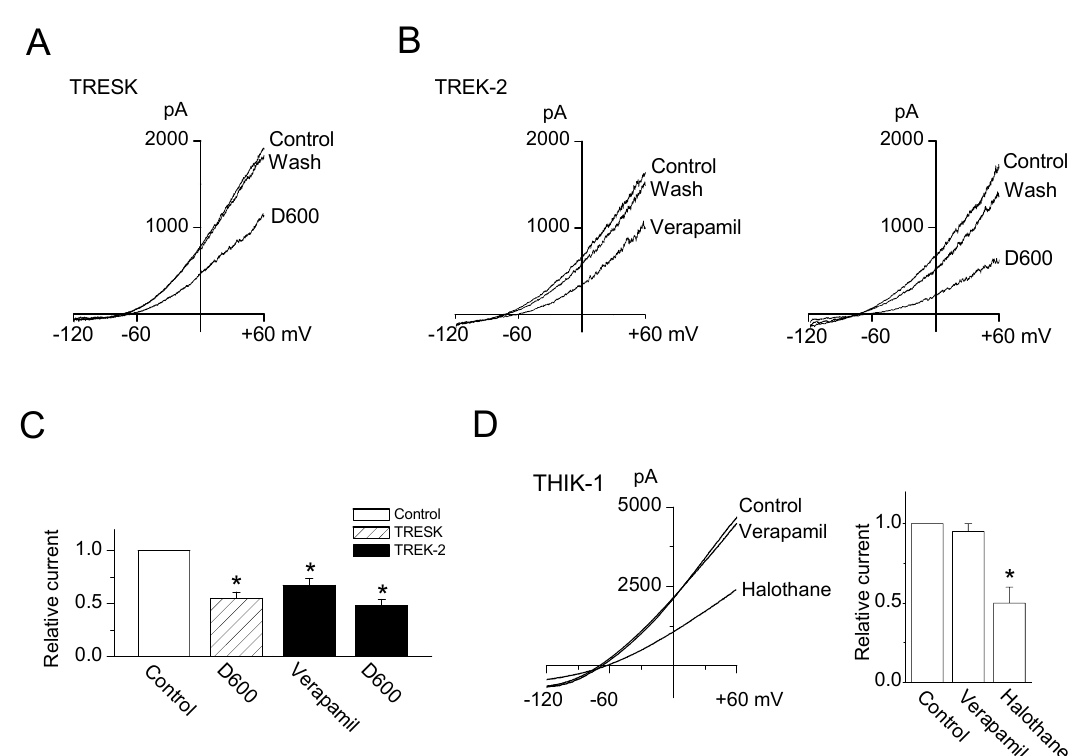
Figure 2. Comparison of verapamil and D600 effects on TRESK and TREK-2 channels ( A ) Effect of D600 on TRESK; ( B ) Effect of verapamil and D600 on TREK-2; ( C ) Summary of the effects of verapamil and D600 on the TRESK and TREK-2 currents. The current levels at +60 mV were determined and analyzed. Data represent the mean ± SD of three repeated experiments. * p < 0.05 compared with the control; and ( D ) Effect of verapamil on THIK-1 current. The THIK-1 current was validated by treatment with halothane. Data represent the mean ± SD of three repeated experiments. * p < 0.05 compared with the control.